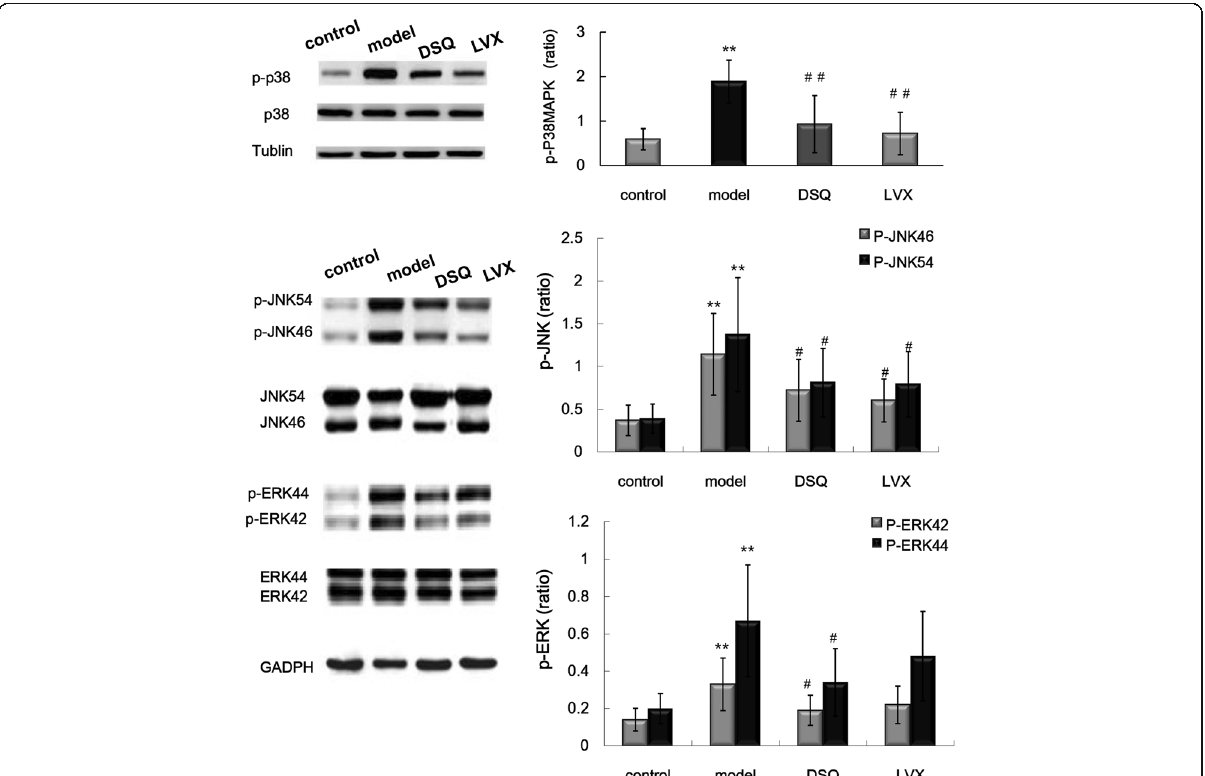
Fig. 4 Phosphorylation of P38MAPK, JNK and ERK1/2 in the lungs in control, model, DSQ and LVX groups ** P <0.01 vs. control group; # P <0.05, ## P <0.01 vs. model group. Values are expressed as mean ± S.D., one-way